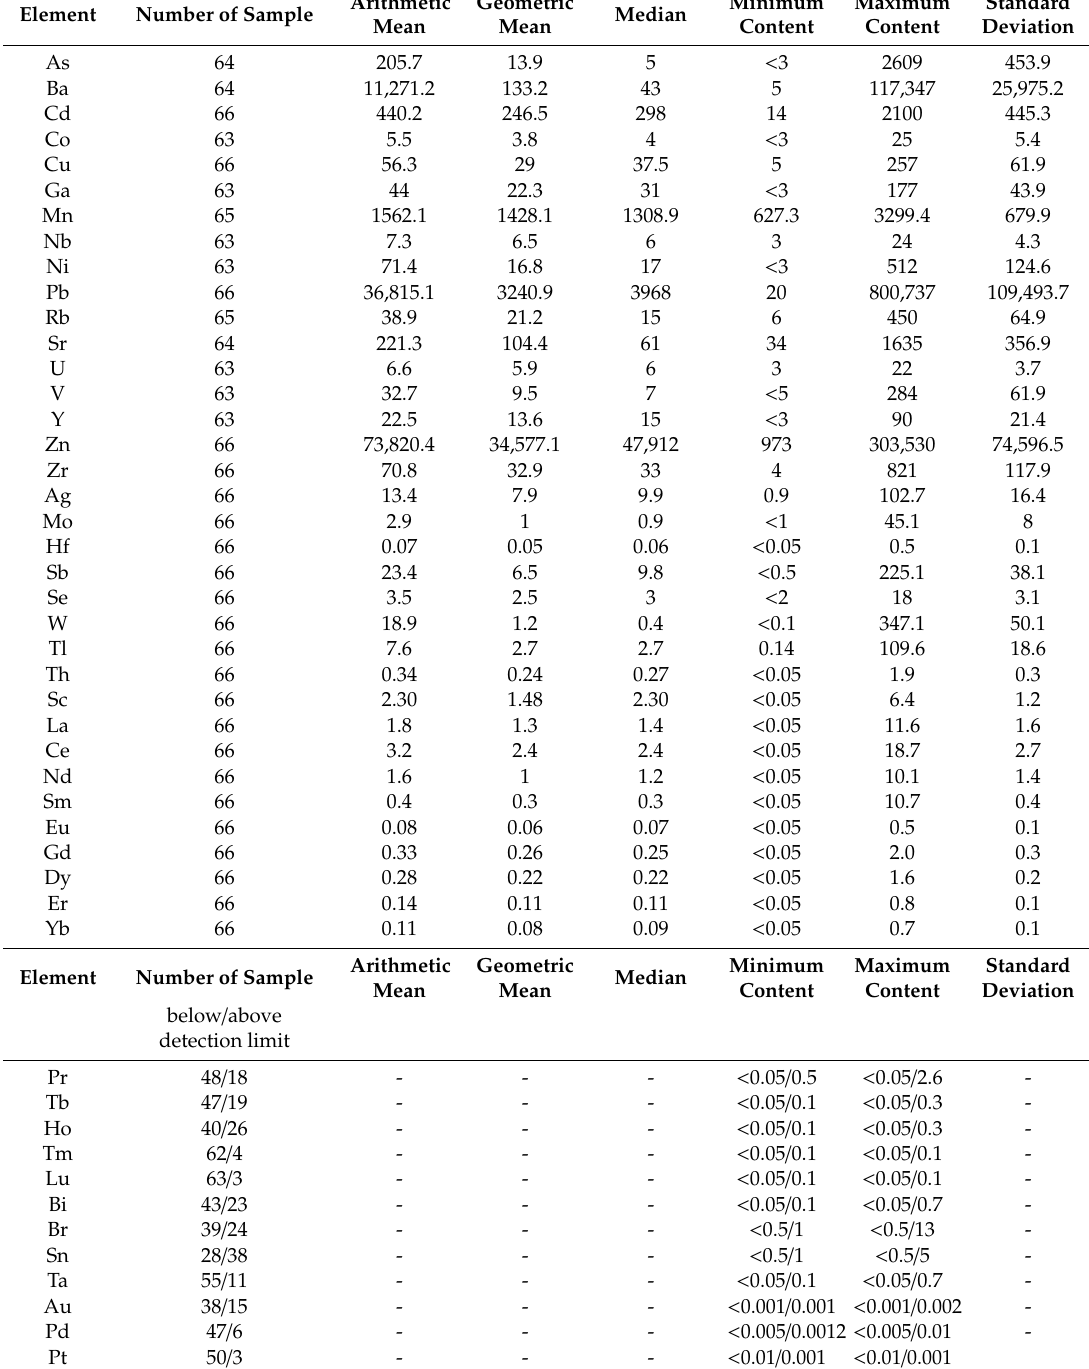
Table 2. Basic statistical parameters for trace elements and main commodities (Zn and Pb) (in ppm) of the bulk-rock samples from Zn-Pb MVT deposits in